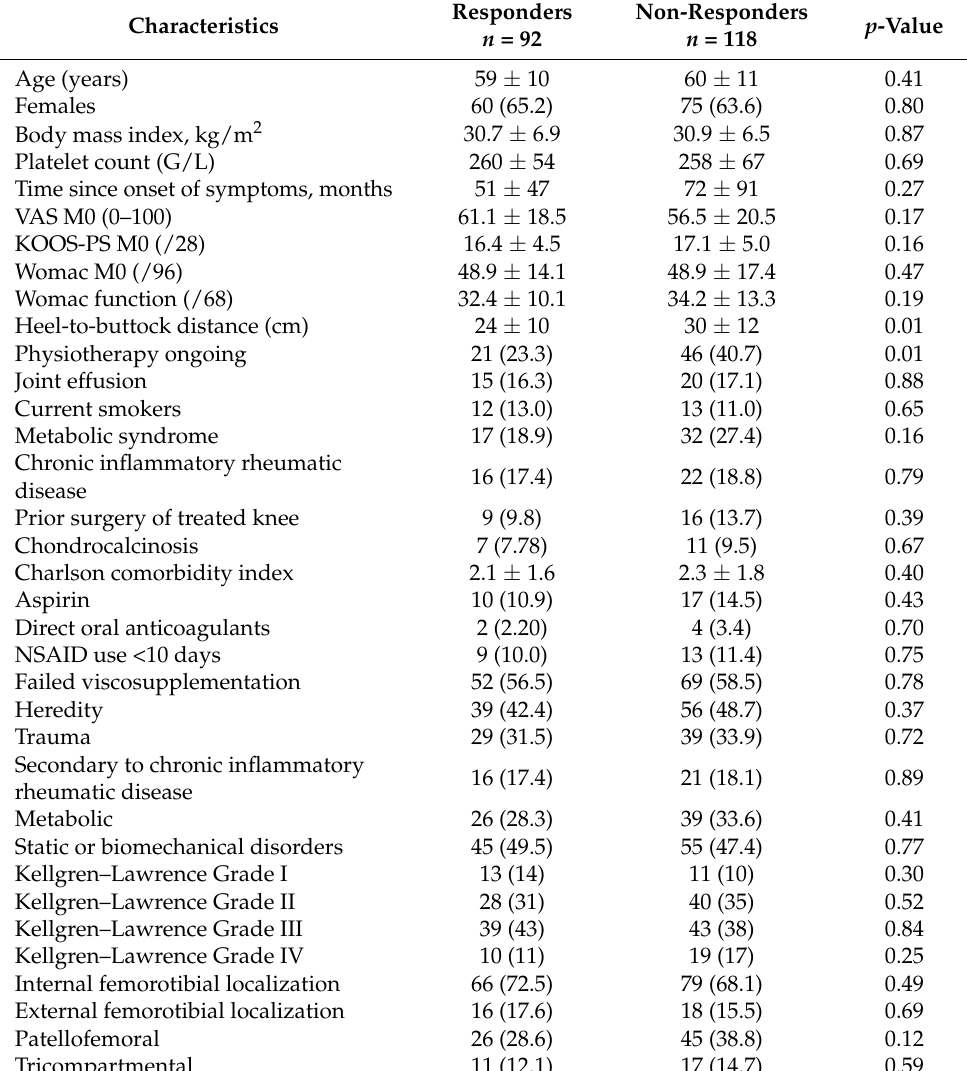
Table 3. Univariate comparison of responders vs.